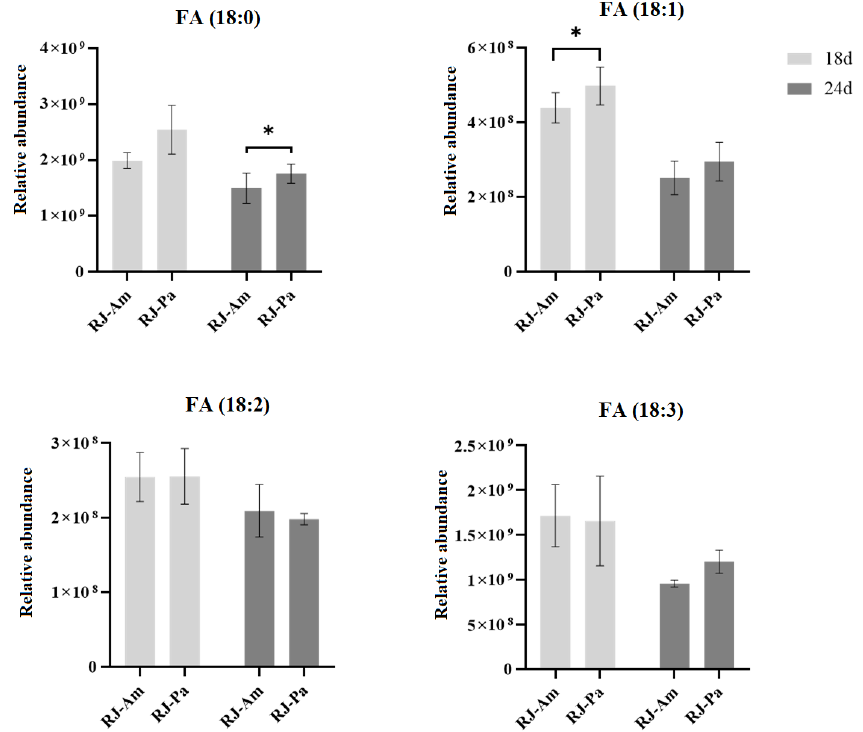
Figure 3. Changes in levels of 18-carbon saturated and unsaturated fatty acids in royal jelly secreted by honeybees fed single bee pollen derived from Acer mono Maxim. (BP-Am) or Phellodendron amurense Rupr. (BP-Pa). Samples were collected on days 18 and 24 after honeybees began feeding on single bee pollen. RJ-Am, royal jelly secreted by honeybees fed BP-Am; RJ-Pa, royal jelly secreted by honeybees fed BP-Pa. *, p -value <